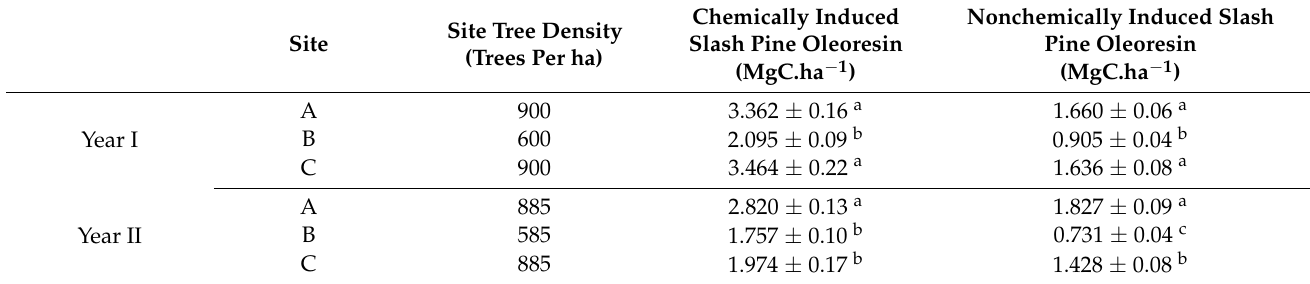
Table 5. Carbon stock in oleoresin biomass harvested from slash pine